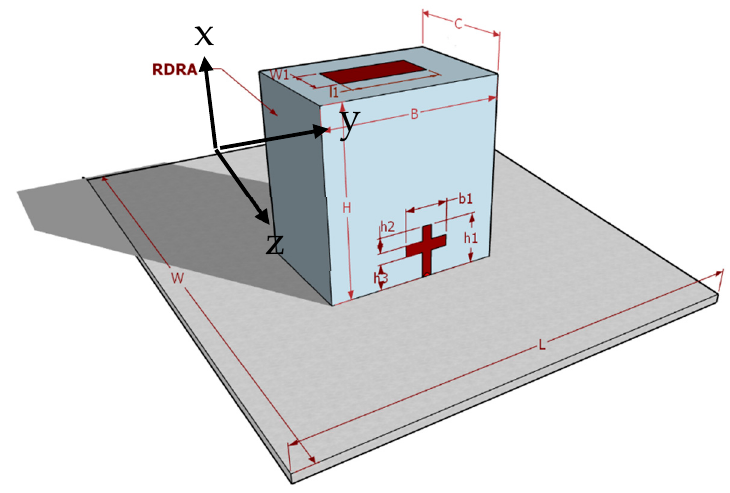
Figure 1. The geometry of the singly fed RDRA (3-D View) 5G Sub6GHz Applications. Linear Polarized DRA